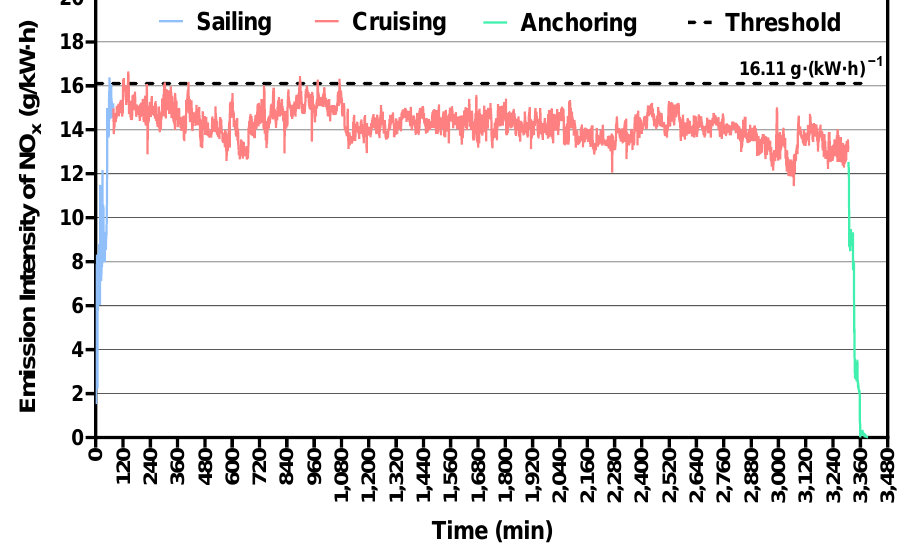
Figure 4. Derivation results of ships’ instantaneous NO x -emission intensity. The results indicate that the NO x -emission intensity of voyaging ships can be calcu- lated when the real-time NO x /CO 2 -concentration ratio and the fuel-consumption rate are obtained. Further, the emissions intensity of NO x for voyaging ships can be evaluated and controlled through comparison with the emission standards. Sulfur content in ship fuel. By substituting the recorded real-time data into the model of the sulfur content of the ship fuel (Formula 2) established in Section 2.3, the sulfur content of the ship fuel at every minute was calculated (Figure 5).